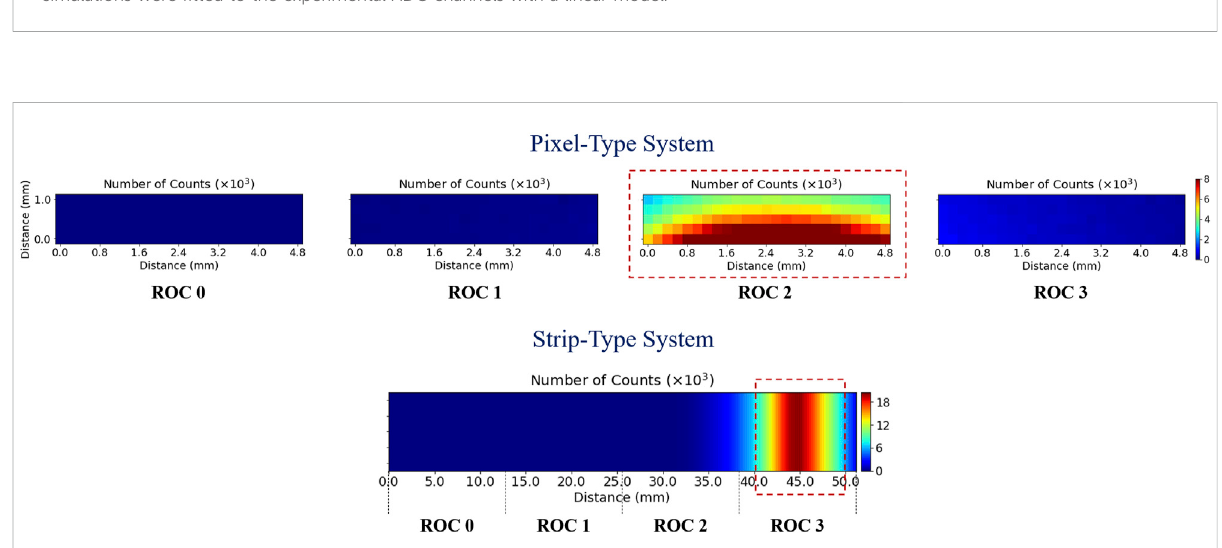
FIGURE 5 Number of particles detected by both systems with a 7 MeV proton beam (not to